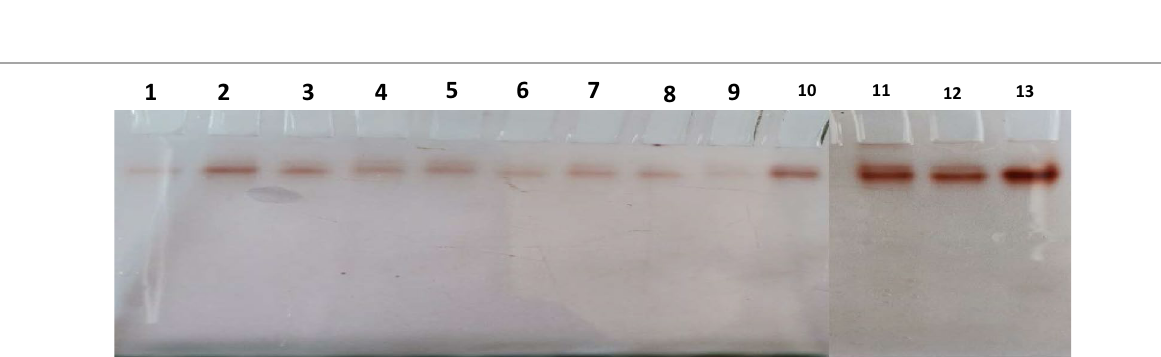
Fig. 5 Electrophoretic patterns of the peroxidase isozymes for the 13 rice genotypes under normal conditions. Lane 1: 8 13 highest five hybrids, respectively =